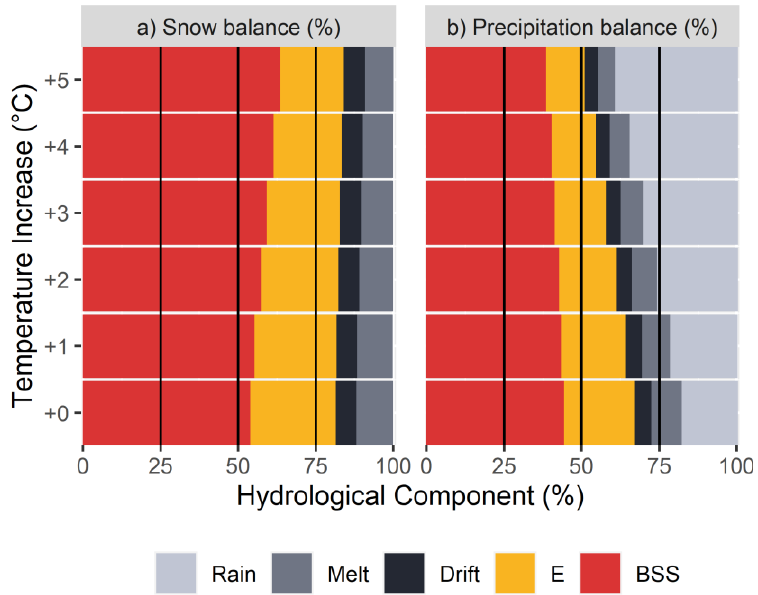
Figure 10. Sensitivity analysis on the UCRB’s mass balance components with the variation of temperature per one degree Celsius added.